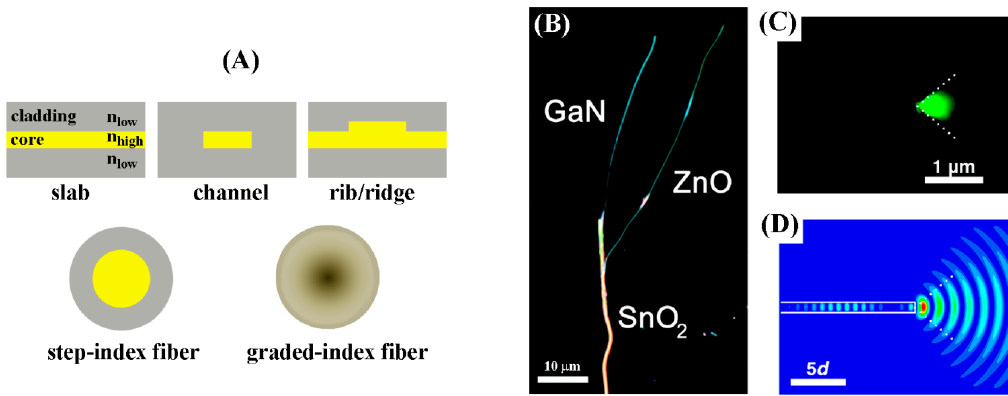
Figure 20. ( A ) Various structures of macroscopic and bulk waveguides are depicted; ( B – D ) 1D nanomaterial-based, subwavelength waveguides are displayed. ( B ) The waveguides are fabricated from using the optical cavities of a GaN NW, SnO 2 nanoribbon, and ZnO NW with diameters between 130–250 nm. Reproduced with permission from Ref. [142] Copyright (2005) Proceedings of the National Academy of Sciences USA; ( C , D ) The conical emission of a low-order guided mode from a ZnO NR is shown in ( C ). The emission angle is approximately 90 ◦ (dotted lines). The image result in ( D ) is from a 2D finite difference time domain (FDTD) calculation of the square of the electric field of a light pulse emitted from a ZnO NR of diameter d . Reproduced with permission from Ref. [143] Copyright (2007) American Chemical Society.